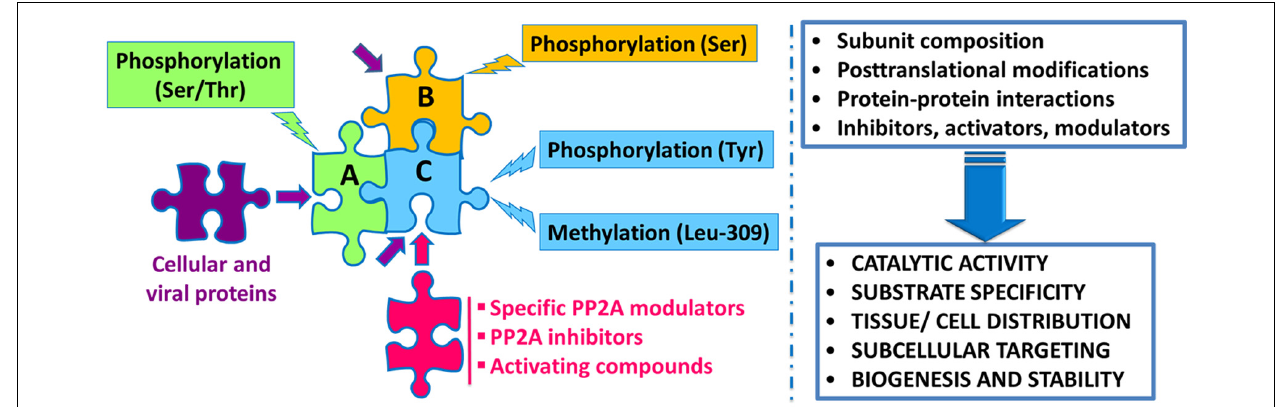
FIGURE 1 | Schematic overview of the intricate regulation of PP2A enzymes. Major PP2A holoenzymes of this very large family ( > 96 enzymes) are heterotrimers containing a scaffolding “A” (one of two isoforms), a catalytic “C” (one of two isoforms), and one variable regulatory “B” subunit (one of twenty three isoforms). PP2A subunits are subjected to post-translational modifications, including methylation of the catalytic subunit on a conserved Leucine-309 residue, and phosphorylation. Endogenous